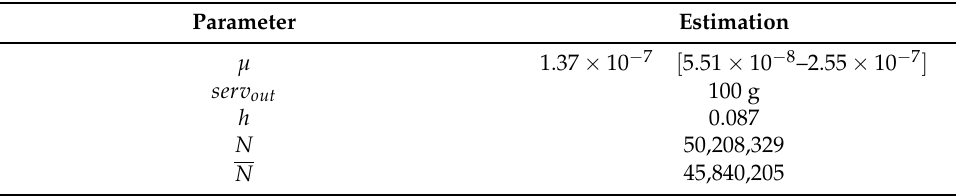
Table 5. General model parameters. A 95% CI is reported between brackets.